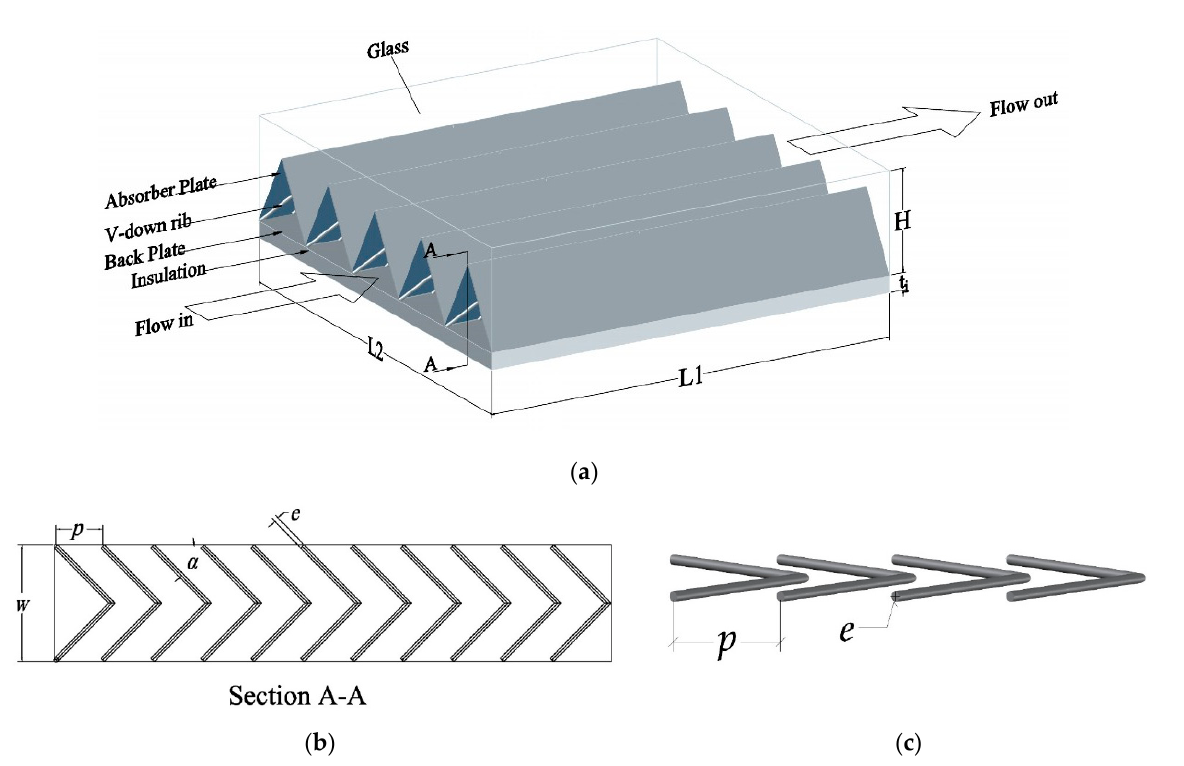
Figure 1. Schematic diagram of ( a ) SAH components ( b ) section A-A shows V-down ribs, and ( c ) a zoomed-in view of V-down ribs.